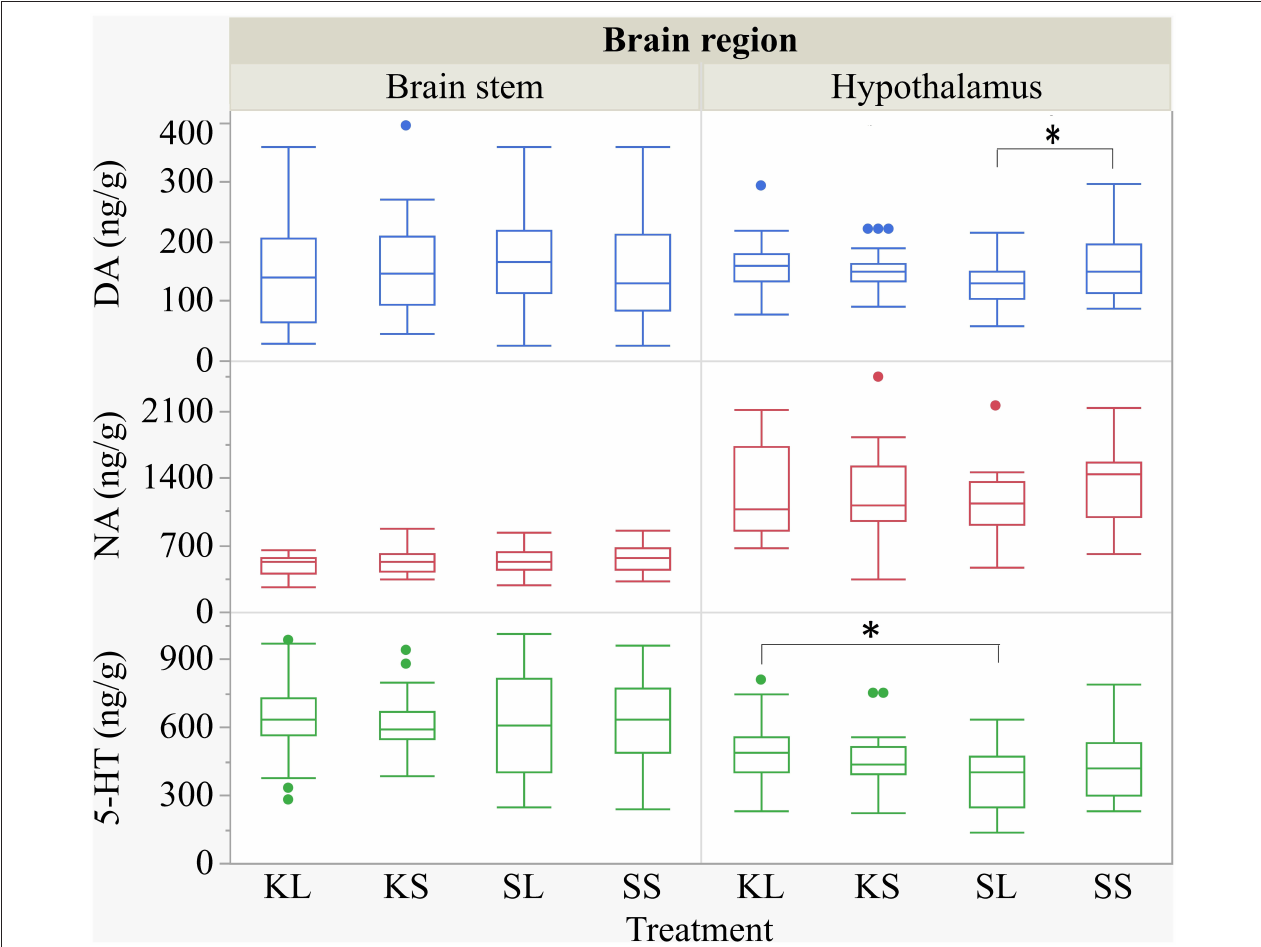
FIGURE 6 | Concentration (ng g − 1 ) of dopamine, noradrenaline, and serotonin in the brain stem and in the hypothalamus of pigs at 72h after the injection with ketoprofen–lipopolysaccharide (LPS) (KL), ketoprofen–saline, saline–LPS, and saline–saline (SS). To improve the readability, two outliers were removed from the figure (one SS and one KL in the hypothalamus). Round dots indicate outliers. Significant differences of planned comparisons between treatments ( p < 0.05) are marked with an